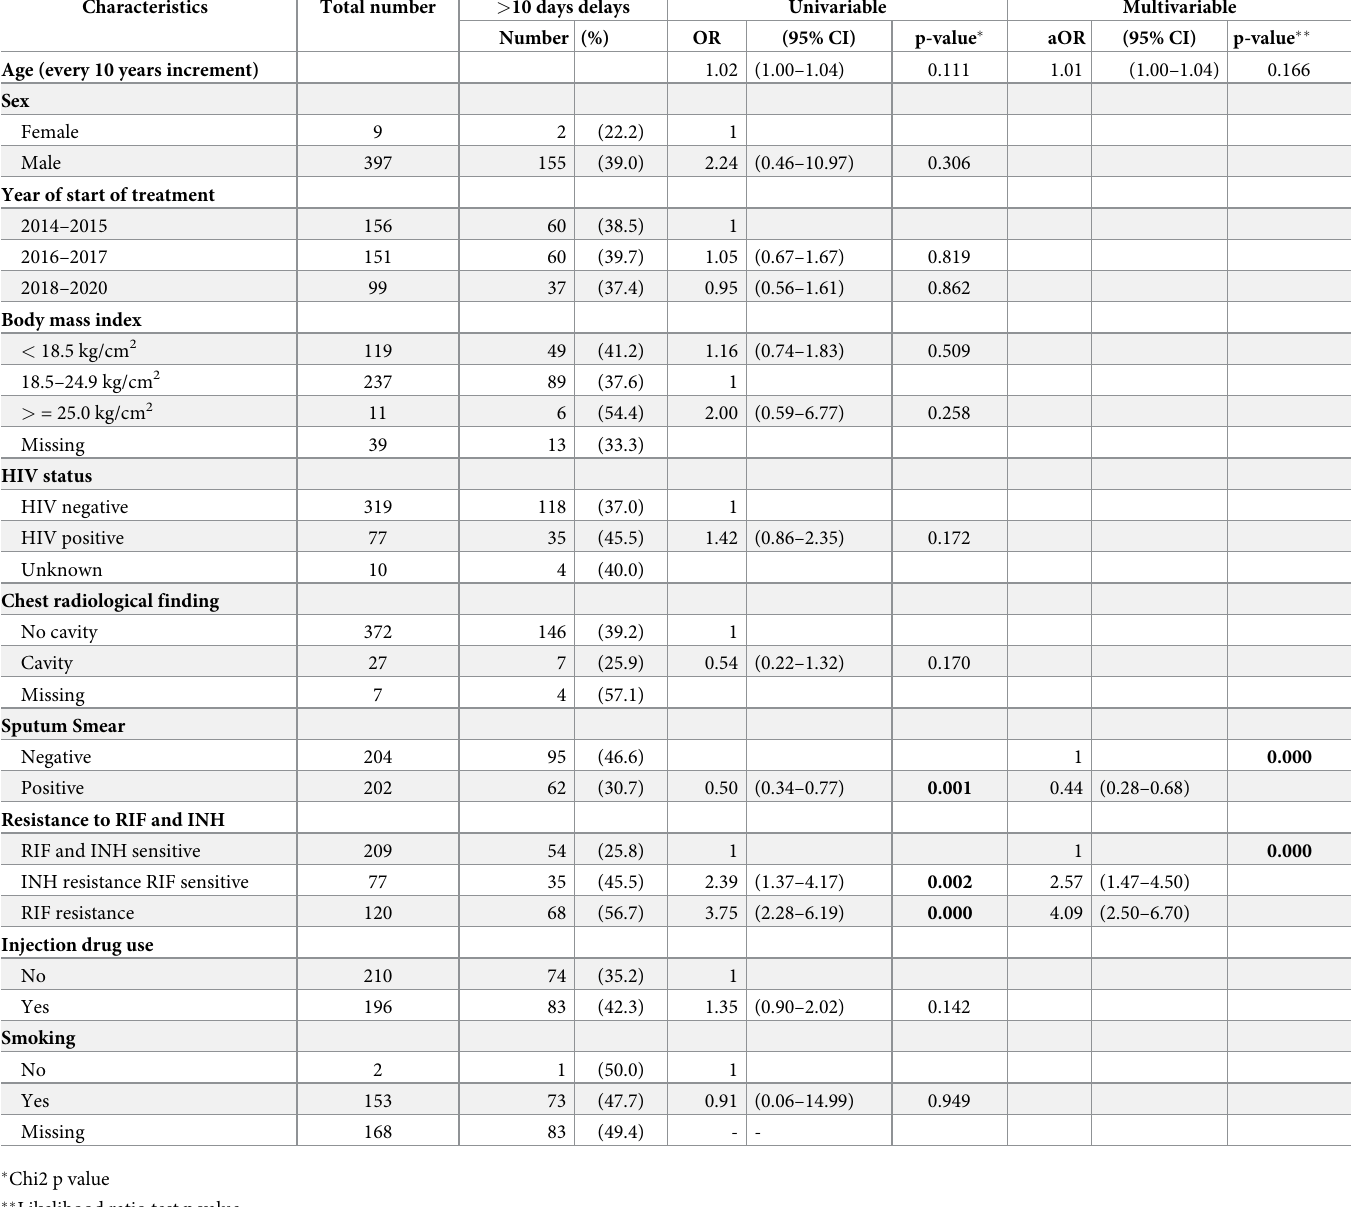
Table 2. Predictors of delay in TB treatment initiation by demographic and clinical characteristics.